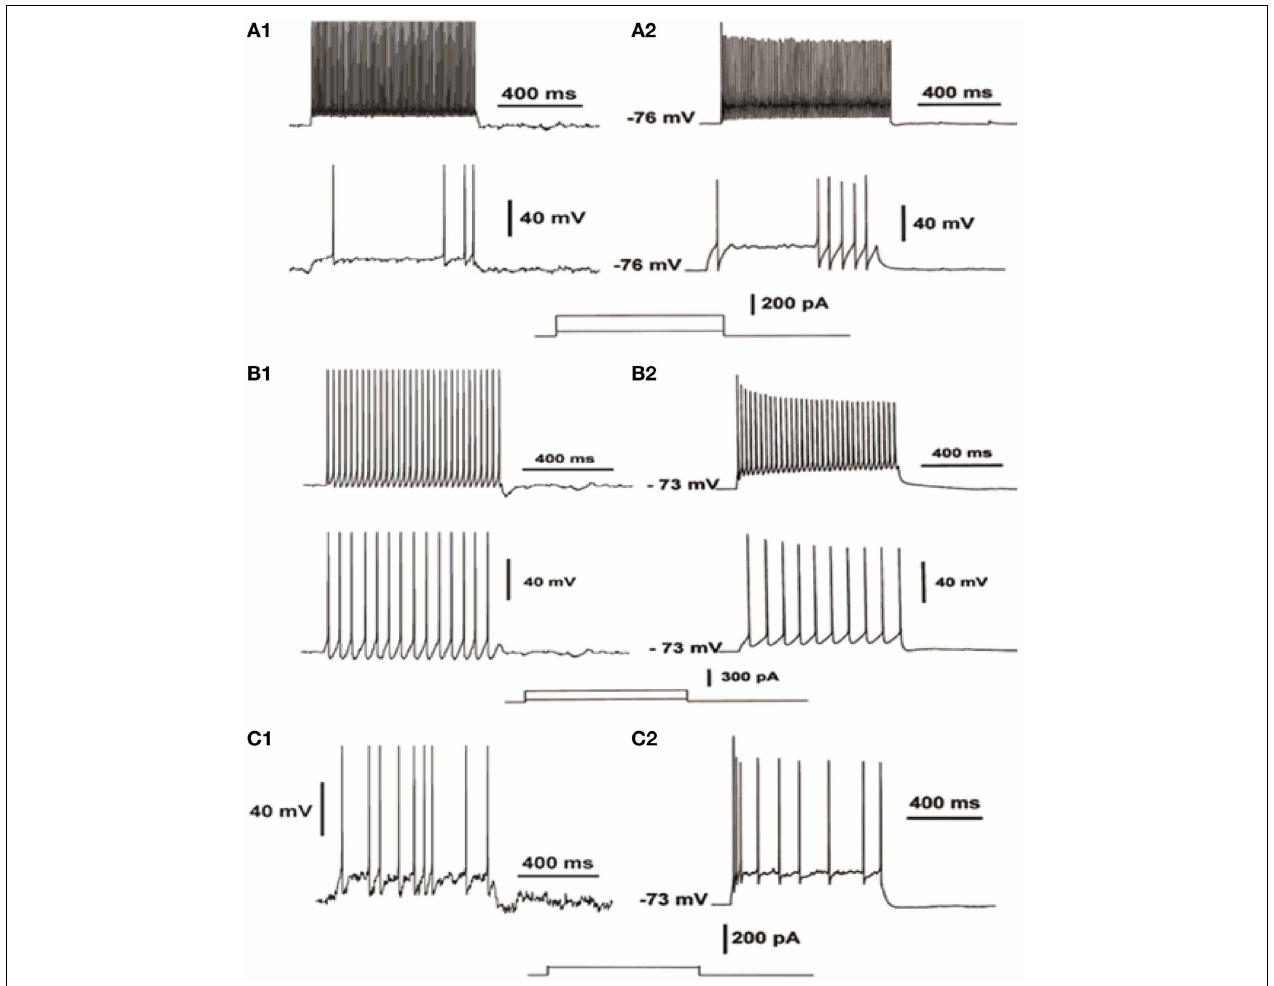
FIGURE 2 | Validation of the electrophysiological characteristics of the FS interneuron (A), the RS interneuron (B) and the IS interneuron model (C). FS neuron model response to increasing depolarizing current injections (A1) compared to experimental data from current-clamp recordings ( A2 , adapted from Cauli et al., 1997), reveal the fast-spiking profile of the FS model. RS neuron model response to increasing